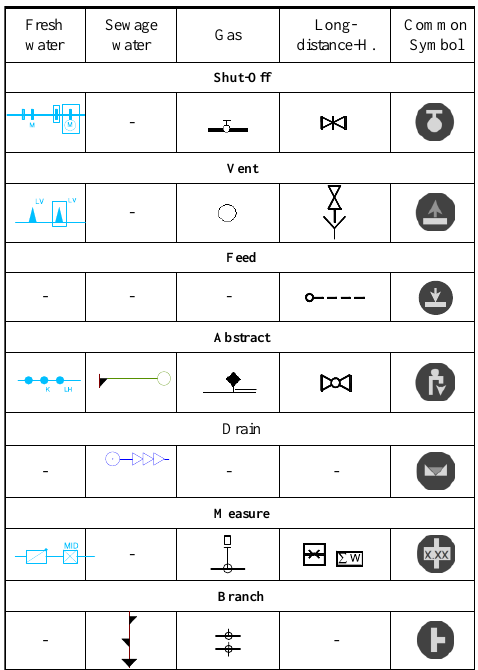
Figure 11. Suppliers' and new designed common symbols for main functions Another key aspect is the symbol placement. To express the spatial location of a network component, the initial position of the symbol is replaced by a color-coded point (compare Figure 9 and 10). Therefore, position information, network, and hierarchy incorporation can be expressed for each symbol. A point was chosen to ensure the graphical distinction of symbol placement and color-boxes. In addition, the circularity of the placement point is comparable to the shape of the symbols and the relation between both becomes apparent. Finally, a graphical link between symbols of identical type (1: n relation) is created expressing the semantic connection between identical objects (Figure 10) and avoiding additional symbol density. According to network affiliation and hierarchy, these links were color-coded and dotted to make them distinguishable from line objects. The links were thinned to reduce their graphical dominance and to avoid misinterpretation, linking connection lines must not cross any pipe or channel – connections are